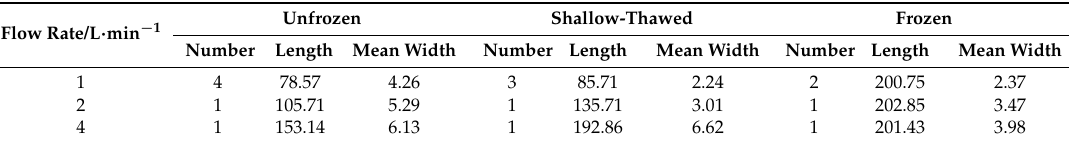
Table 2. The rill length and width under different slopes and flow rates after erosion